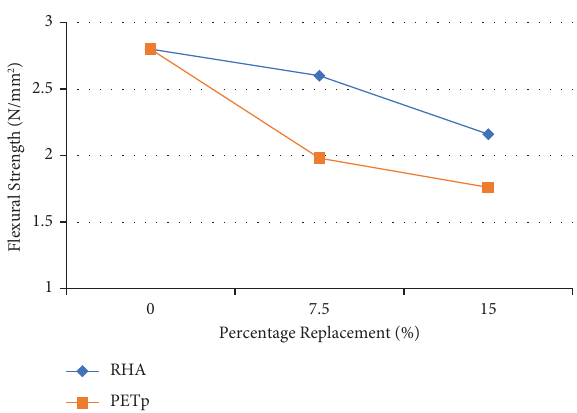
Figure 7: Efects of RHA and PETp on the fexural